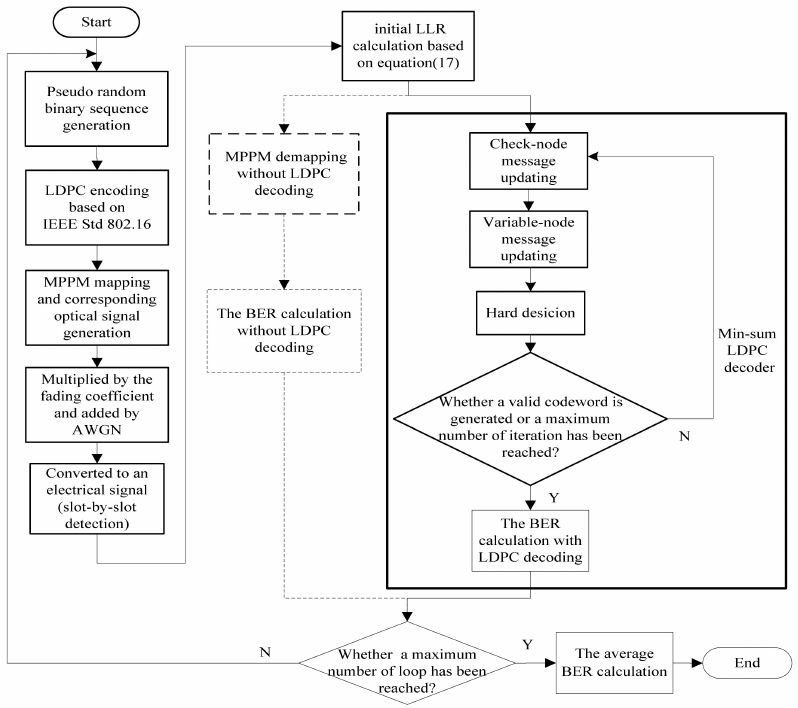
Figure 2. The flowchart for studying the effect of turbulence on UWOC using MPPM scheme.